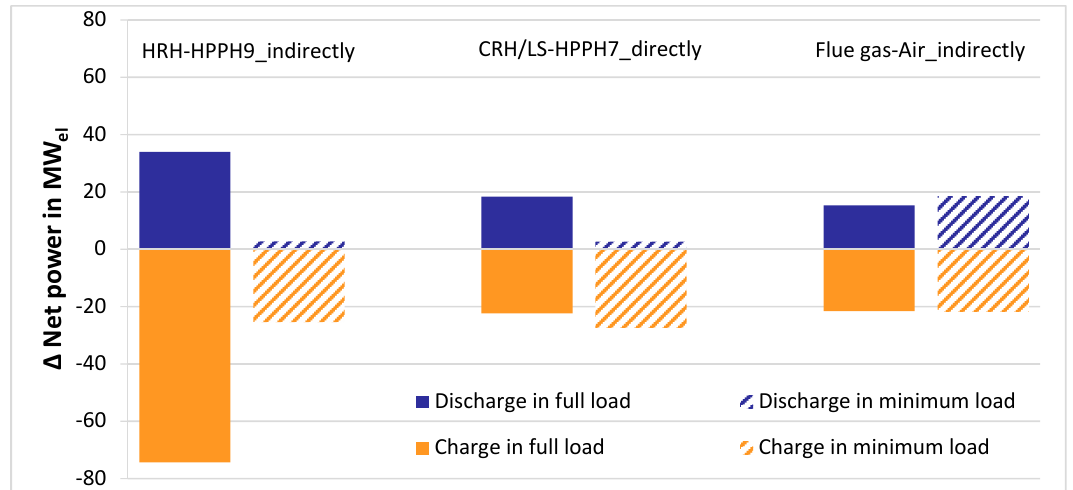
Figure 4. Change in net output during charging and discharging processes of the TES lead concepts at different operating points of the power plant.